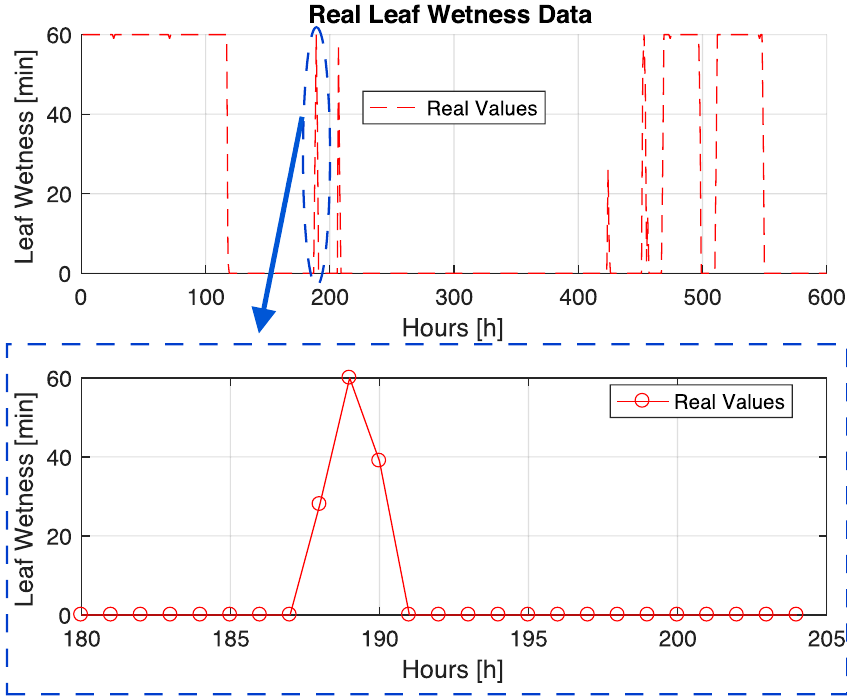
Figure 7. Zoom in on real leaf wetness values between hour range [180, 204]. Red circles represent the hourly acquired leaf wetness